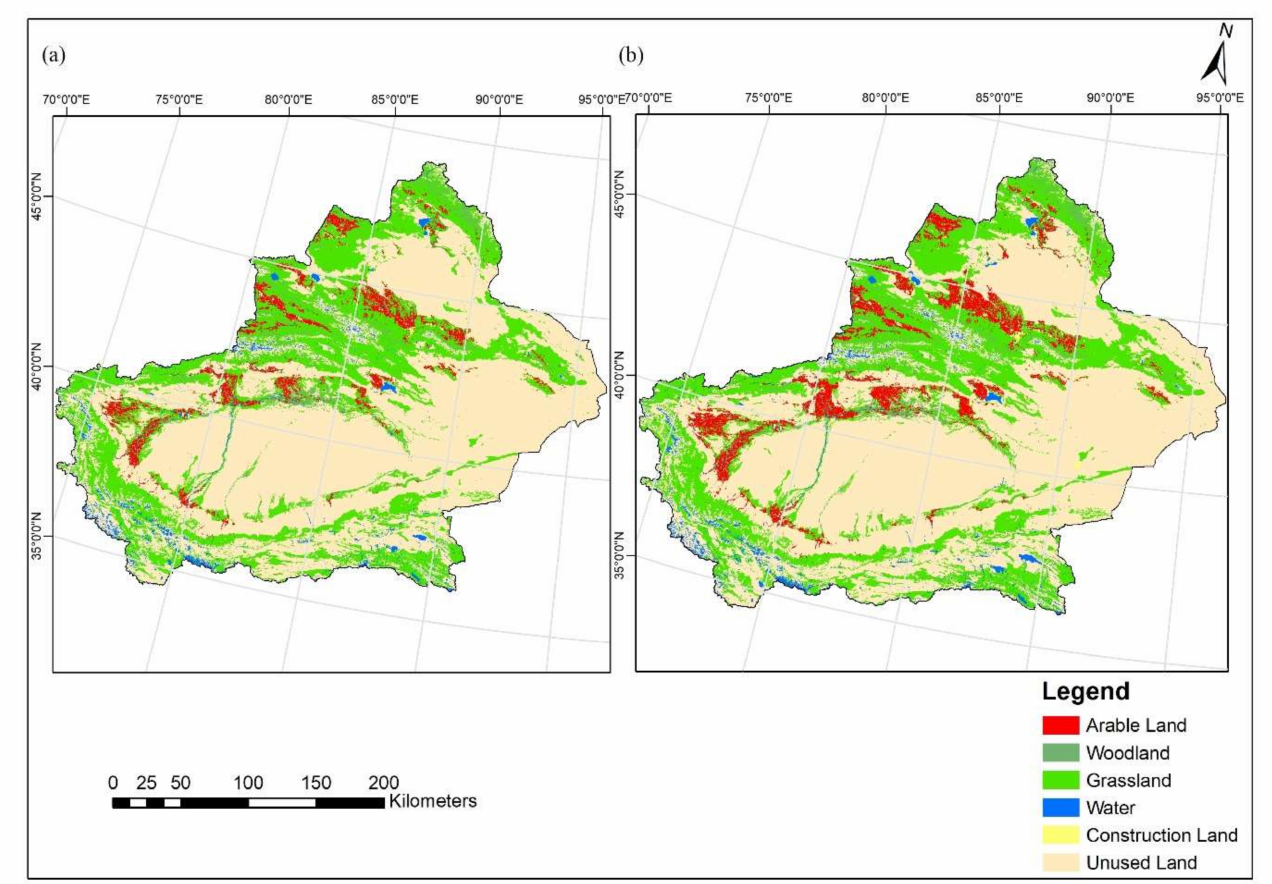
Figure 9. ( a ) LULC in Xinjiang in 2000; ( b ) LULC in Xinjiang in